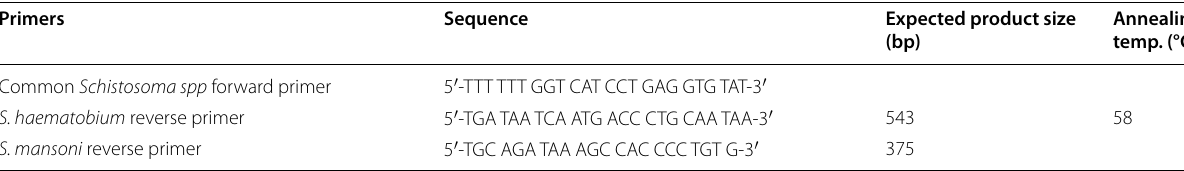
Table 1 Used primers and their sequences Primers Sequence Common Schistosoma spp forward primer